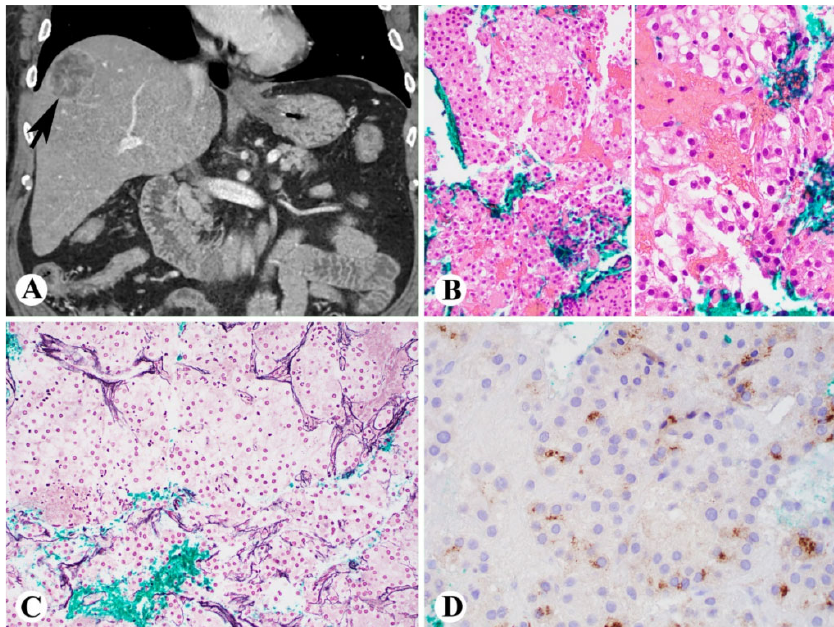
Figure 3. Steatohepatitic type of hepatocellular carcinoma (HCC) in a 60-year-old female with history of nonalcoholic steatohepatitis. ( A ), Computer tomography scans showing a 4.8 cm low-attenuation mass (arrow, coronal); ( B – D ), Liver needle core biopsy showing well-differentiated HCC ( B ); loss of reticulin framework ( C ); and focal positivity of glypican 3 ( B , H&E stain, left 100×, and right 400×; C , reticulin stain, 100×; D , immunohistochemistry for glypican 3, 400×).